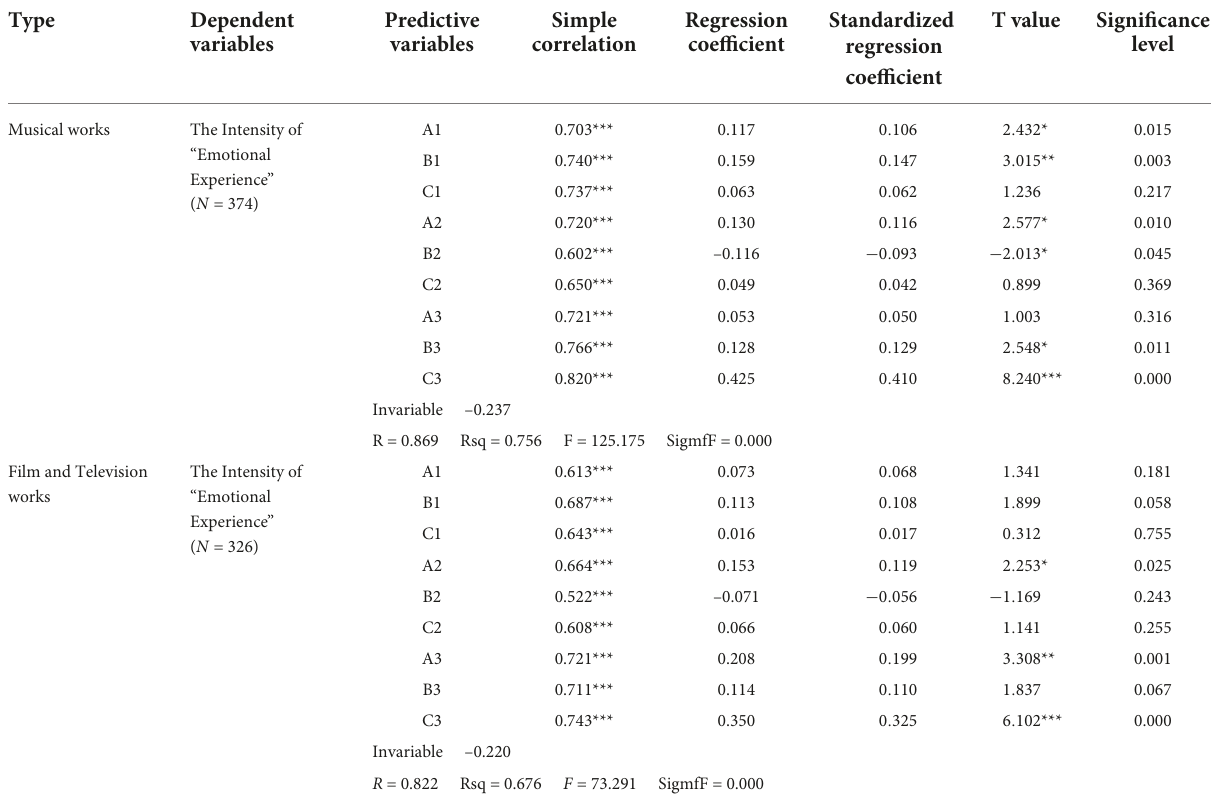
TABLE 8 The regression analysis of emotional